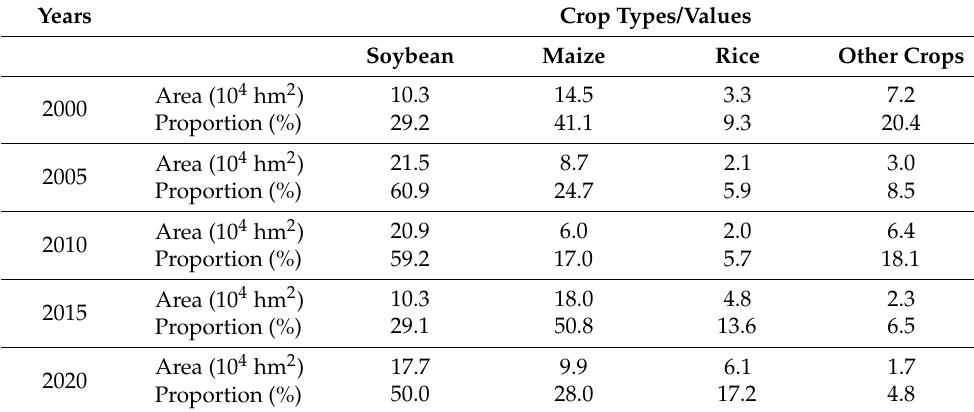
Table 2. Area of major crops in Hailun County.